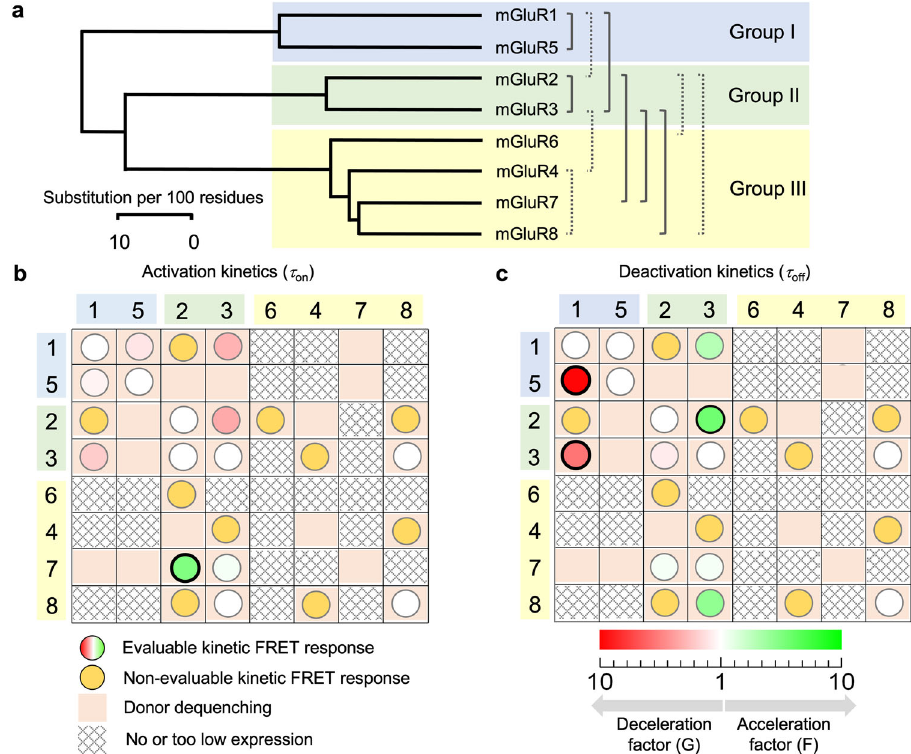
Fig. 5 Overview of the speci fi c functional interactions in heterodimeric mGluRs. a Phylogenetic tree with seven functional interactions speci fi ed by activation and deactivation time constants (solid brackets) and four functional interactions identi fi ed by smaller, kinetically not quanti fi able responses (Stippled brackets). b Matrix summarizing relative activation kinetics (circles) of the heterodimers among the eight subunits mGluR1-mGluR8 with respect to the homodimers and donor dequenching (salmon fi elds). The amount of the kinetic effects, within each column, are color-coded according to the scale in c, providing a factor of acceleration ( F , green) and deceleration ( G , red) with respect to the homodimers. For example, the intensive green circle in row 7 column 3 reads that activation in mGluR2/7 is strongly accelerated with respect to mGluR2 by the color-coded factor F. Signi fi cant differences are indicated by a black bold rim of the circles. White circles indicate an equal time course to the homodimer of the column. The main diagonal contains the properties of the homodimers. c Matrix summarizing deactivation kinetics of the heterodimers. Same symbols as in b